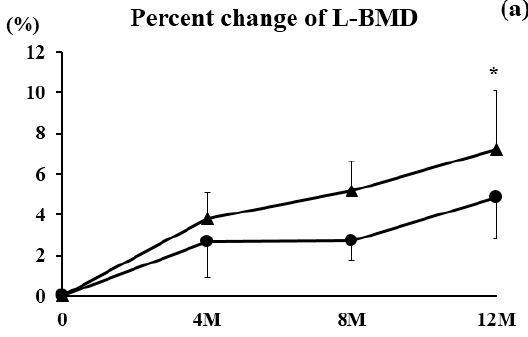
Figure 3. Percent changes in lumbar bone mineral density (L-BMD) ( a ) and bilateral total hip BMD (H-BMD) ( b ) over the 12-month study period. Closed circles show the denosumab monotherapy group and closed triangles show the combination group. Double asterisks (**) denote significant Figure 3. differences ( p < 0.01) at each time point compared with pretreatment in the denosumab monotherapy or combination groups. Double hashtags (##) show significant differences ( p < 0.01) between the denosumab monotherapy and combination groups at each time point.